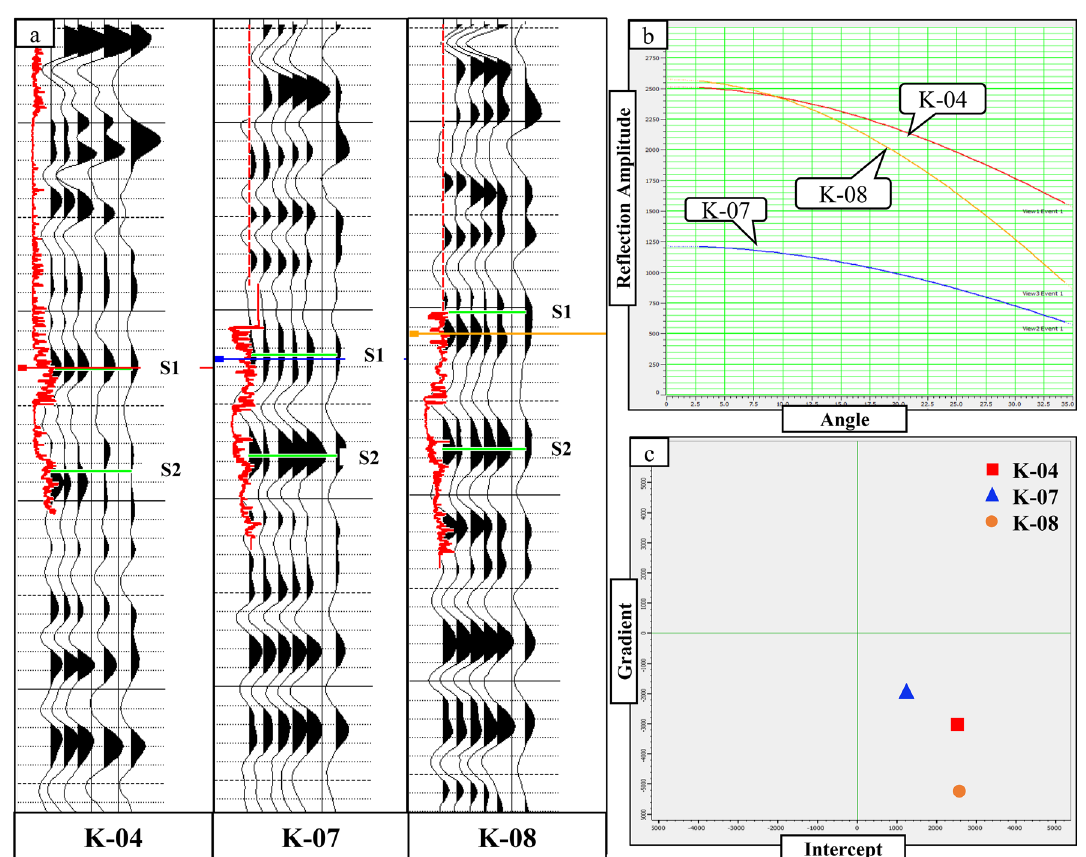
Fig. 12 a Comparison of AVO response from synthetic seismic angle gathers at three wells location, b angle versus reflection amplitude curves showing class I response (a positive normal reflection coeffi- cient and a negative gradient) related to S1 level with shale as cap-